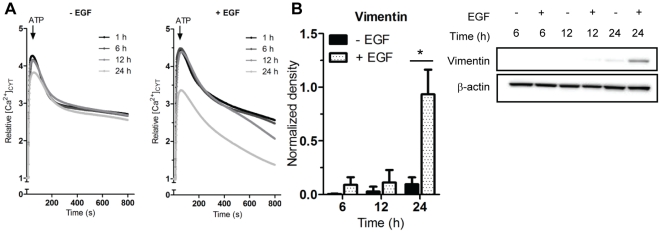
Expression of vimentin protein and functional alterations in the response to ATP.A, MDA-MB-468 cells were serum starved and treated with EGF for 1, 6, 12 and 24 h prior to measuring [Ca2+]CYT with 1 mM ATP. Data are shown as the average relative [Ca2+]CYT from 9 wells from 3 independent experiments. B, Representative immunoblot for vimentin protein after EGF treatment (left) and pooled data (right) normalized to the β-actin loading control. Values represent the mean ± S.D for 6 pooled wells from 3 independent isolations. Statistical analysis was performed using two-way ANOVA and Bonferroni post-tests; * P<0.05.